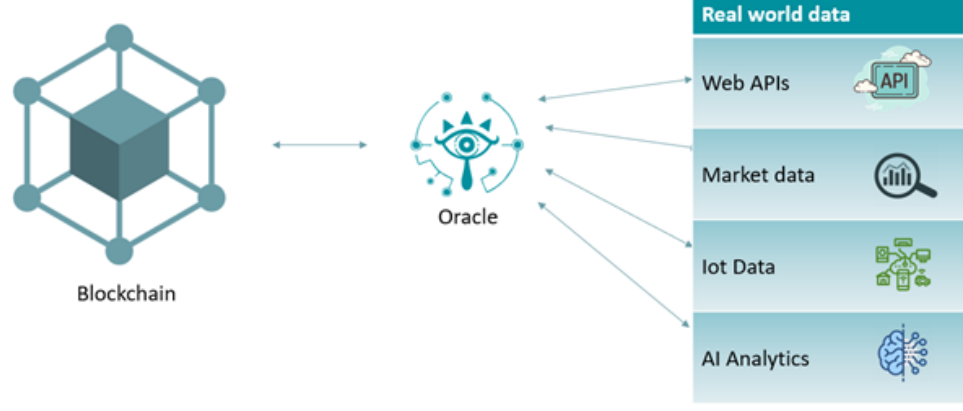
Figure 6. Oracle role representation in a blockchain environment elaborated by the